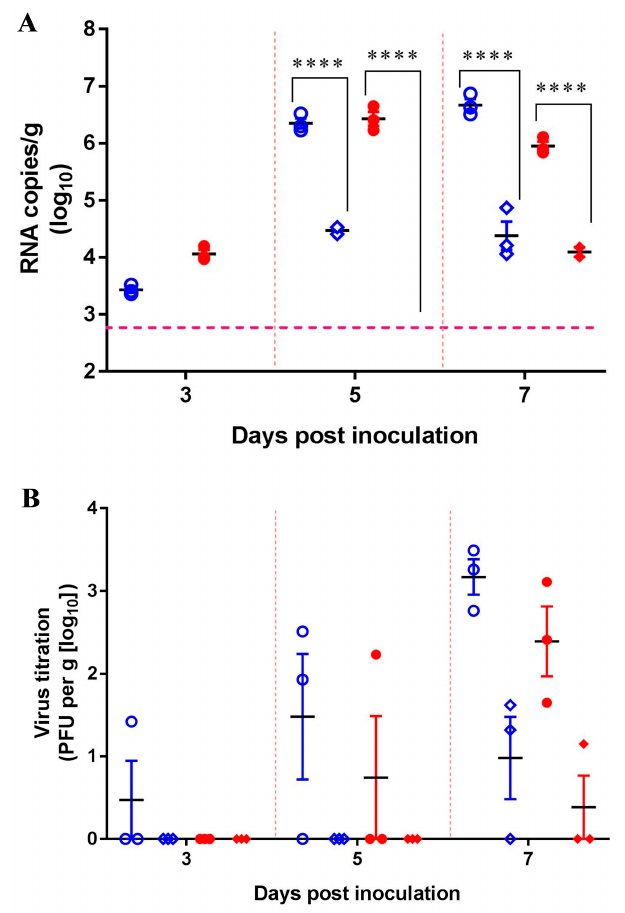
Figure 5 . Aerosol transmission of JEV in mice. The mice were infected i.n. with 10 6.0 pfu/50 μ l of the SCYA201201 or SA14-14-2 virus, respectively, and were housed in a cage with a double-walled wire partition that permitted airflow but prevented direct contact. The sentinel animals were added at 24 h post-infection. The mice were sacrificed, and their lungs were harvested at 3, 5, and 7 dpi. The SCYA201201 was marked with hollow symbols (infected with ○ and sentinel with ◇ ) and the SA14-14-2 was marked with solid symbols (infected with ● and sentinel with ◆ ). ( A ) The viral RNA load in the lungs was measured using real-time RT-PCR assay. The horizontal dotted lines indicate the limit of detection (**** P ˂ 0.0001). ( B ) The virus titer in the lung samples were determined by the plaque assay.